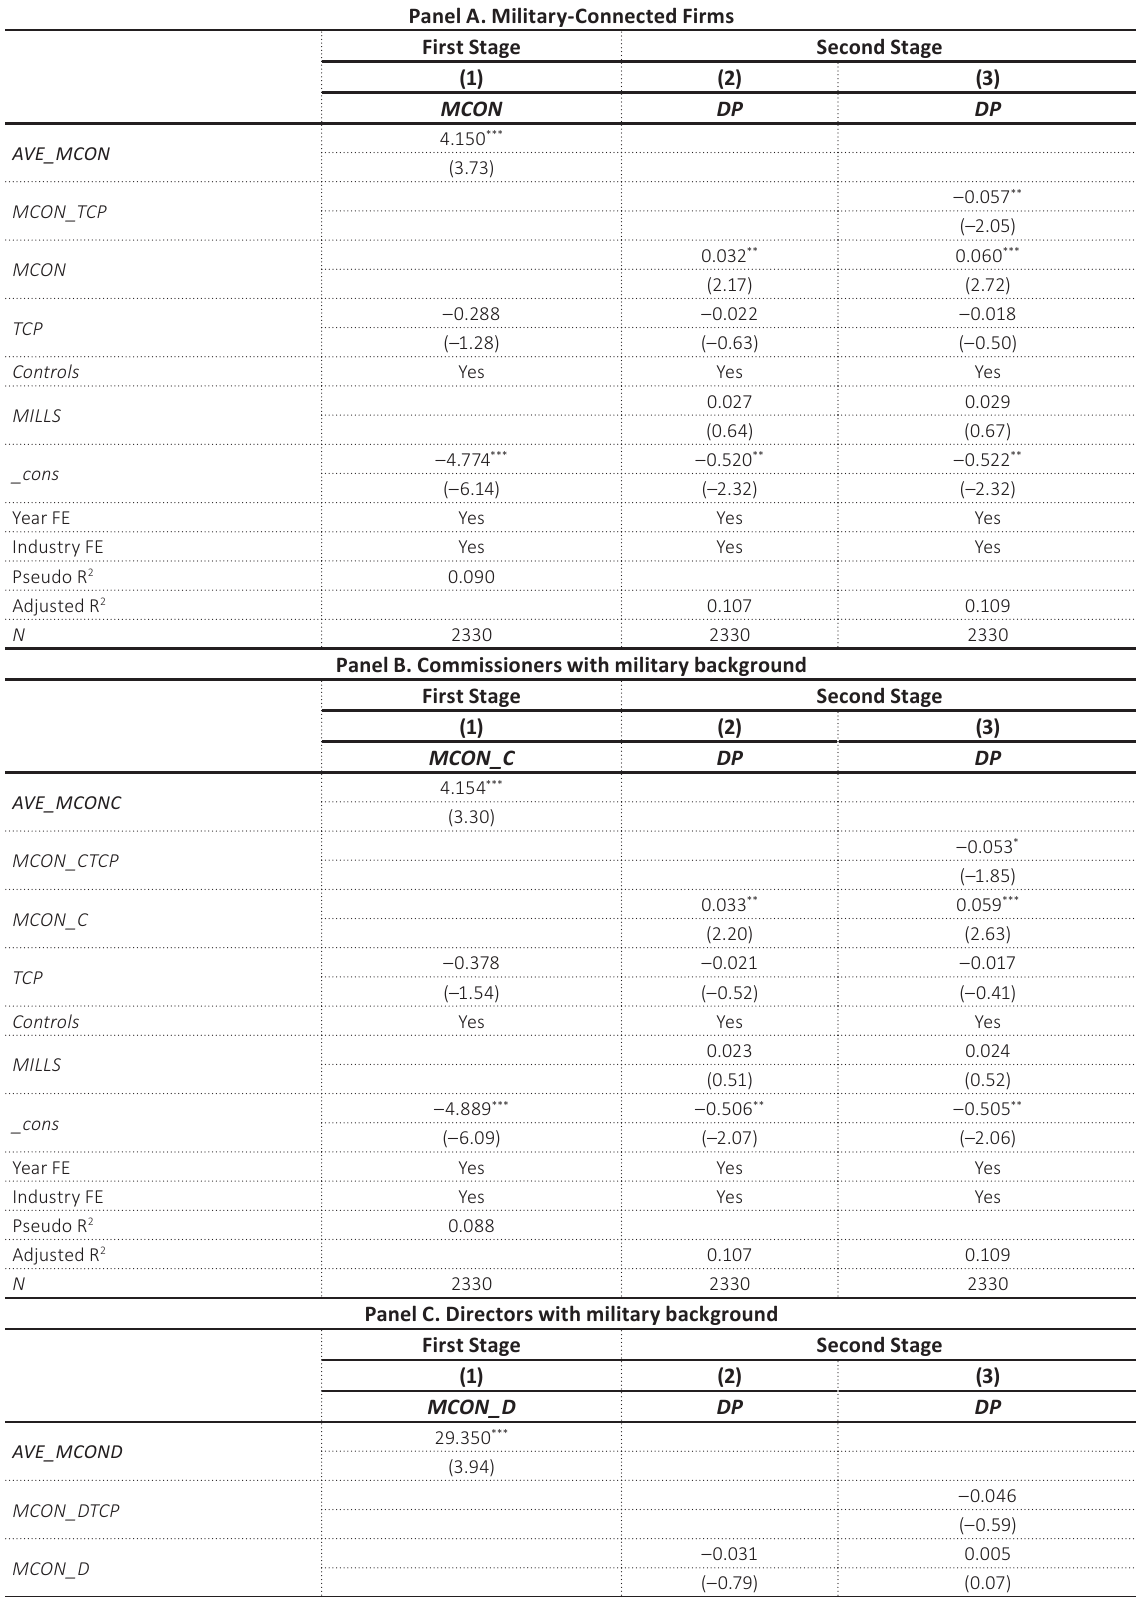
Table 8. Heckman’s two-stage